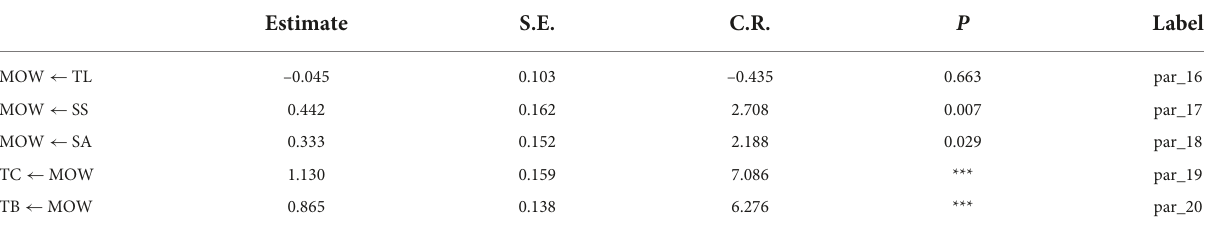
TABLE 6 Regression weight